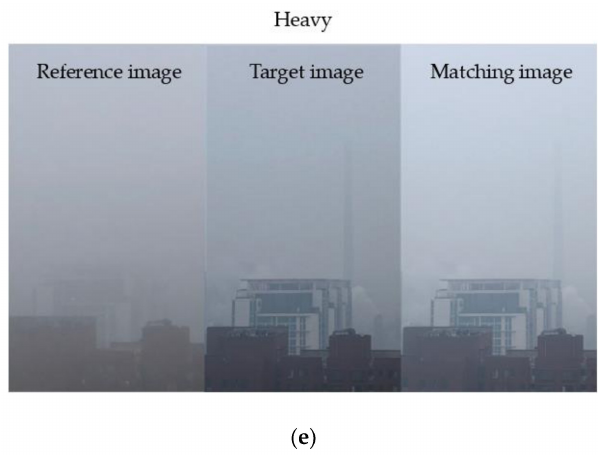
Figure 6. Image matching. ( a ) is the result of a matching image with a level of excellent; ( b ) is the result of a matching image with a level of good; ( c ) is the result of a matching image with a level of light; ( d ) is the result of a matching image with a level of moderate; ( e ) is the result of a matching image with a level of